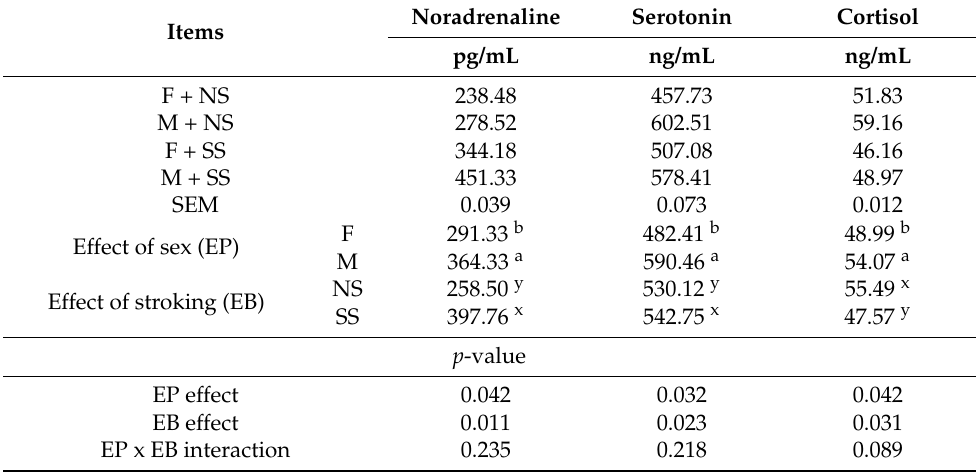
Table 2. Noradrenaline, serotonin, and cortisol levels in the blood serum of dogs in relation to the sex and the use of the stroking stimulus ( n =